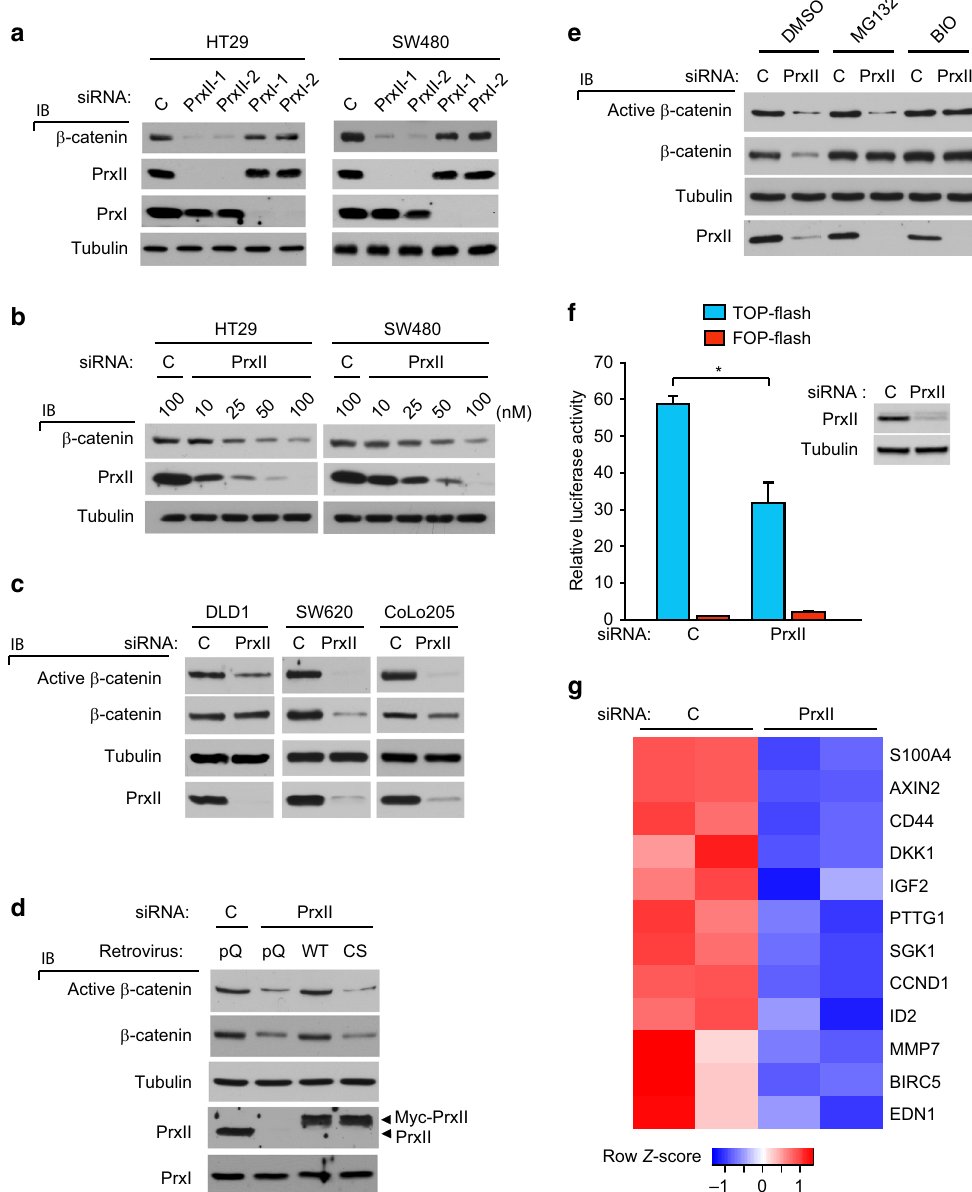
Fig. 2 PrxII is required for stabilization of oncogenic β -catenins in APC-mutant CRC cells. a and b ΗΤ 29 and SW480 cells were transfected with a set of speci fi c siRNAs against PrxI and PrxII a or different concentrations of PrxII-1 siRNA b for 48 h and immunoblotted (IB) for total β -catenin. c DLD1, SW620, and CoLo205 CRC cells were transfected with control or PrxII-1 siRNA and immunoblotted for indicated proteins. Active β -catenin was immunoblotted with antibody speci fi cally recognizing β -catenin unphosphorylated on S37/T41. d HT29 cells were transfected with control or PrxII-1 siRNA for 24 h and then infected with retroviruses expressing siRNA-resistant PrxII WT and C51/172S mutant (CS) for additional 24 h. Empty retrovirus (pQ) was used for control. The exogenously expressed PrxII is tagged at C-terminus with a Myc epitope. e Control and PrxII-depleted SW480 cells were treated with proteasome and GSK3 β inhibitors (25 μ M MG132 and 2.5 μ M BIO) for 1 h. Control vehicle was dimethyl sulfoxide (DMSO). f Control and PrxII-depleted SW480 cells were transfected with FOP fl ash or TOP fl ash luciferase reporter plasmid for measuring β -catenin/TCF transcription activity. Luciferase activity was measured in triplicate by dual-luciferase assay. Data in the graph are means ± s.d. of relative luciferase activities after normalization of transfection ef fi ciency ( n = 3, * P < 0.002). g Heat map depicting the signi fi cant downregulation of β -catenin/TCF-dependent gene expression by PrxII depletion in HT29 cells. Duplicate experiments are shown in parallel. A representative immunoblot (IB) from three independent experiments is shown. Fire fl y luciferase-speci fi c siRNA was used as control catenin levels, indicating that the peroxidase activity of PrxII is siRNA-resistant forms of PrxII. The PrxII WT perfectly restored levels of both total and active β -catenins to those comparable with control siRNA-transfected cells, indicating the speci fi c role of PrxII in regulating β -catenin level (Fig. 2d and Supplementary Fig. 3a). In contrast, the expression of peroxidase-inactive mutants (C172S and C51/172 S) of PrxII 24 did not restore β -